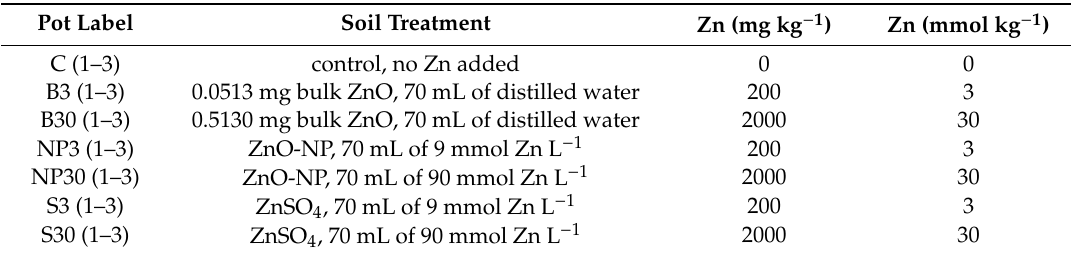
Table 3. The concentration of Zn (II) in di ff erent forms in replicated pots of soil (21 pots in total). Pot